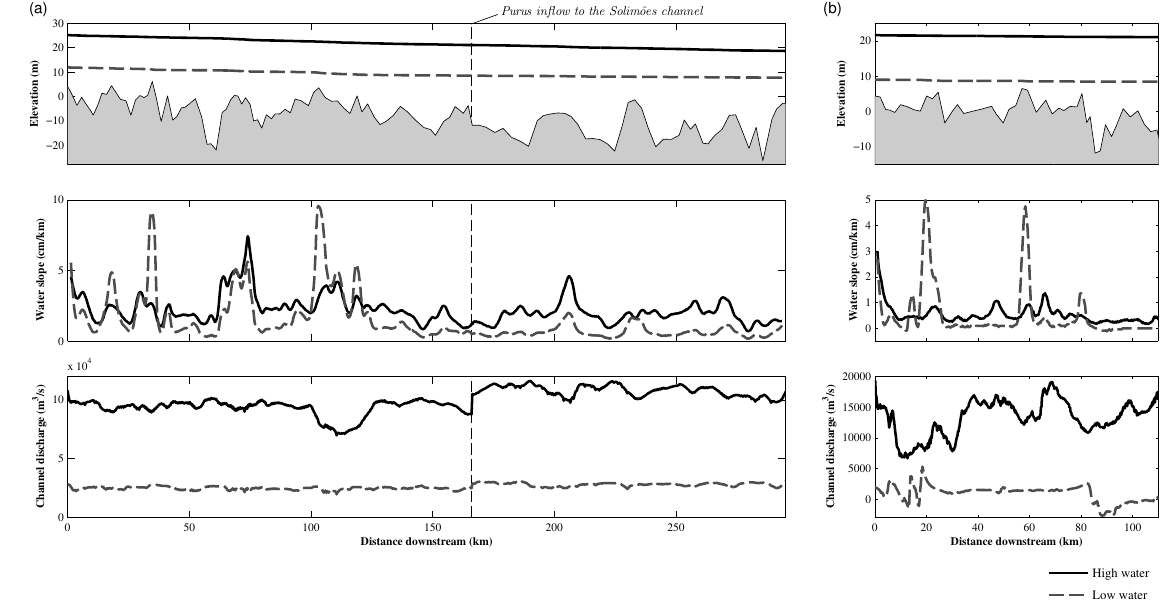
Figure 4. LISFLOOD-FP model output: 1-D channel profiles at high and low water for (a) the Solimões and (b) Purus rivers. Top: water- surface elevations along the channel (channel bed topography is shown in grey shaded area); middle: water-surface slope; bottom: channel discharge. The vertical line in the plots in (a) indicates the location of the Purus inflow to the Solimões.